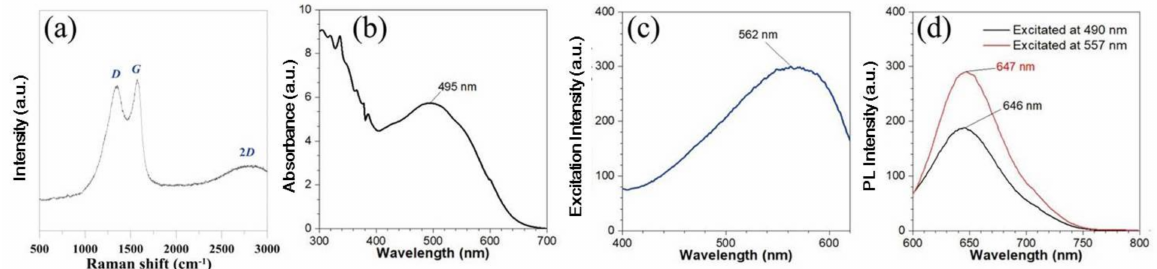
Figure 2. ( a ) Raman spectra of N-CQD sample measured with 514-nanometer argon laser at 10 mW power, ( b ) UV–vis absorbance spectrum, ( c ) photoluminescence (PL) excitation, and ( d ) PL emission spectra of N-CQDs excited at 490 and 557 nm.